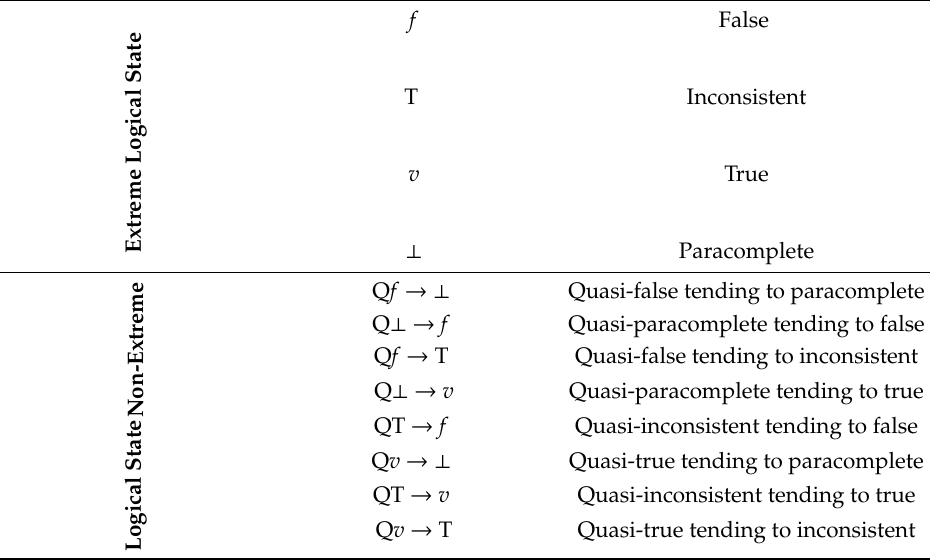
Figure 4. Unitary square of the Cartesian plane of the PAL 2v. Table 6. Unitary square of the Cartesian plane zones.